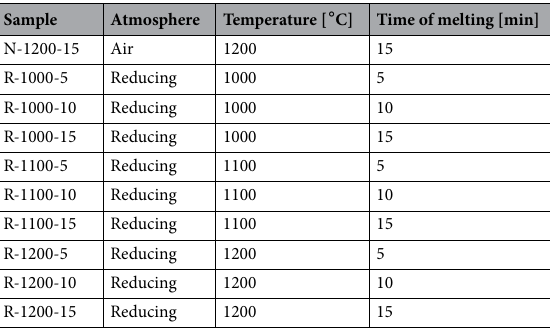
Table 1. List of the synthesized samples with the synthesis parameters (atmosphere, melting temperature and